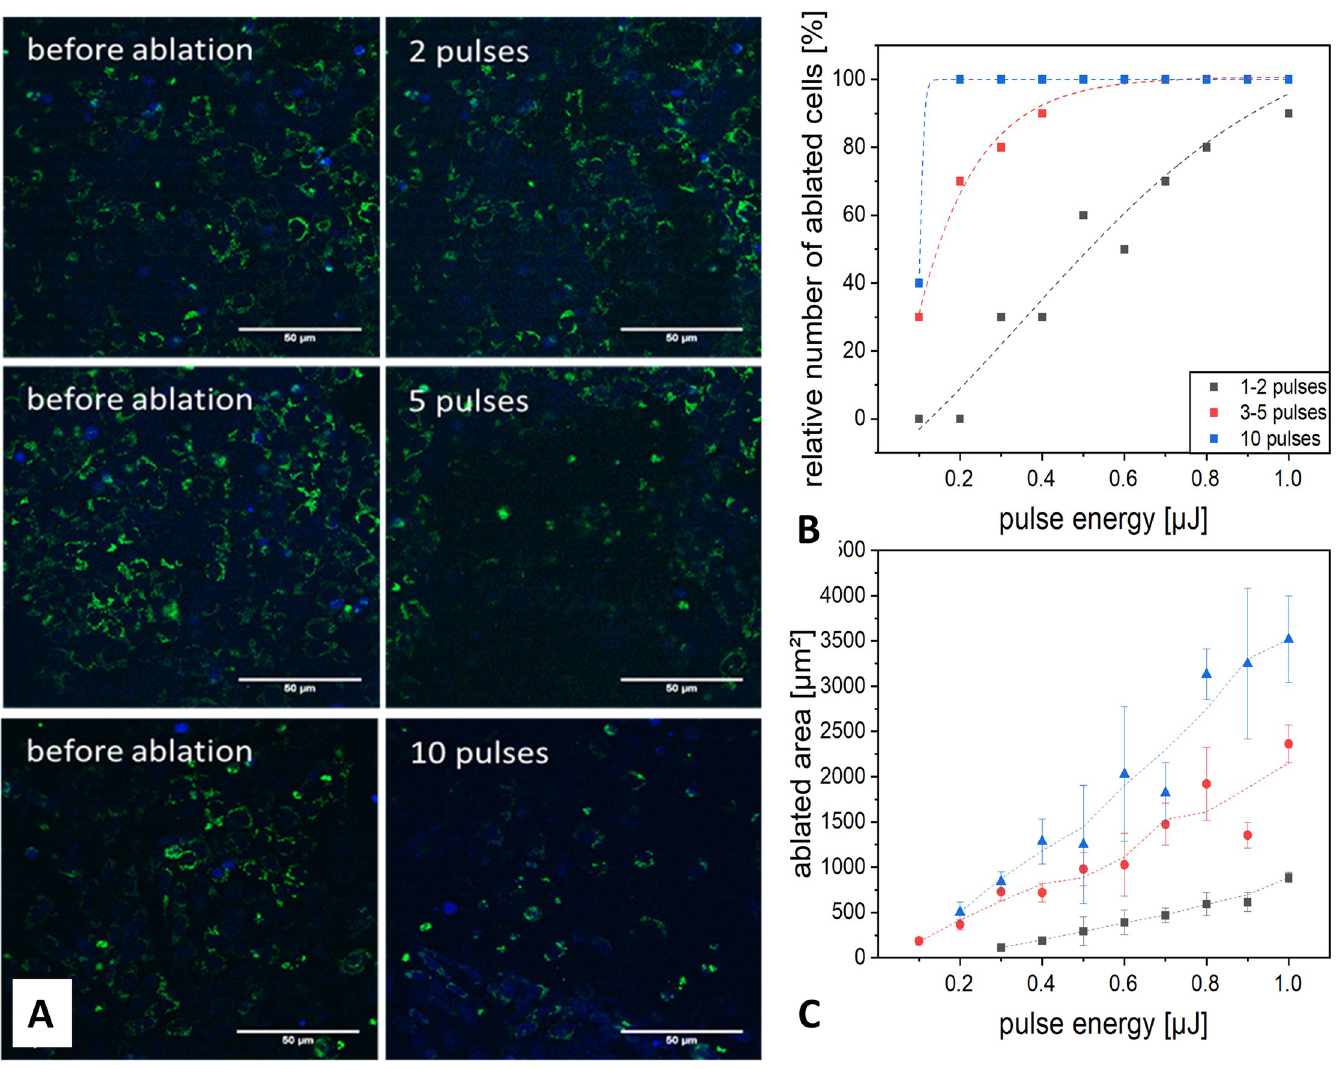
Fig 3. Microscopical images of the targeted ablation of ZMTH3 cells: ( A ) Expressing a mitochondrial-tagged red fluorescent protein (green) and Calcein AM (blue) using varying pulse sequences. ( B ) Dependence of the ablation efficiency on the pulse number and pulse energy based on 10 targeted cells with a sigmoidal fit function. With 10 pulses, all cells were ablated for pulse energies of more than 0.2 μ J. ( C ) Dependence of the ablated area on the pulse